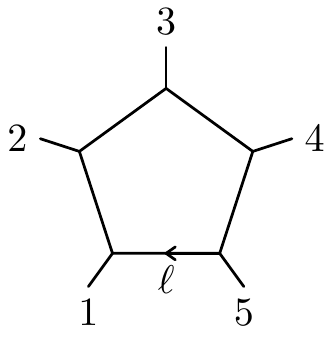
( ‘ ) from equation (1.15). The 1 | 2 , 3 , 4 , 5